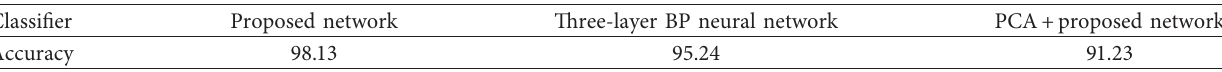
Figure 11: Relationship between accuracy and number of iterations. Table 3: Comparison of accuracies (%) of various